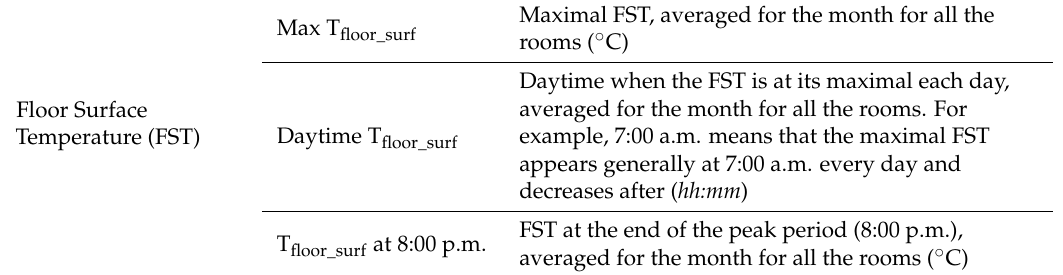
Table 3. Studied parameters for the parametric study.